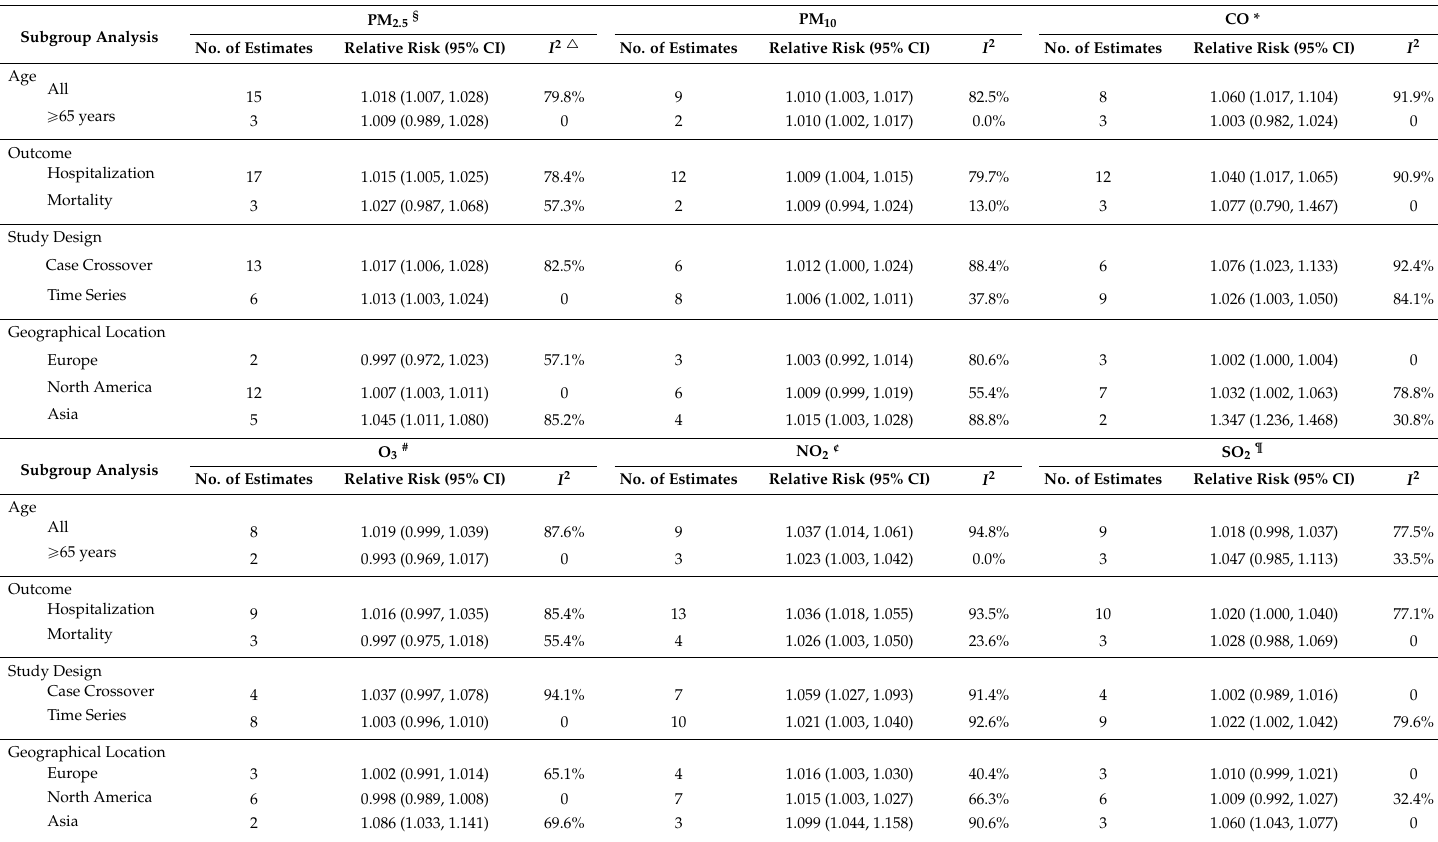
Table 1. Subgroup analysis stratified by age, outcome, study design and geographical location across air pollutants. Subgroup